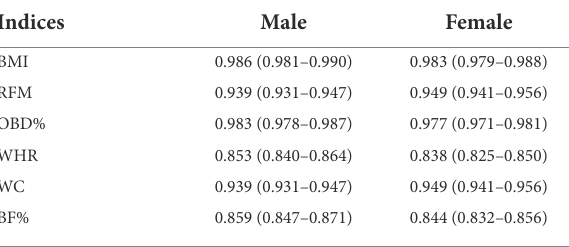
TABLE 4 AUC by the anthropometric indices.